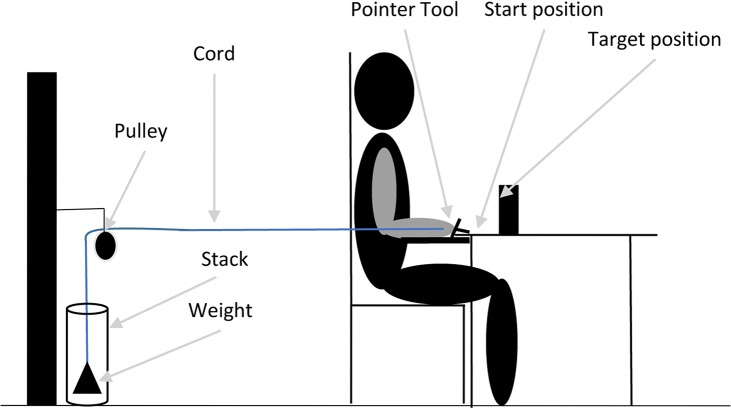
Experimental set-up.